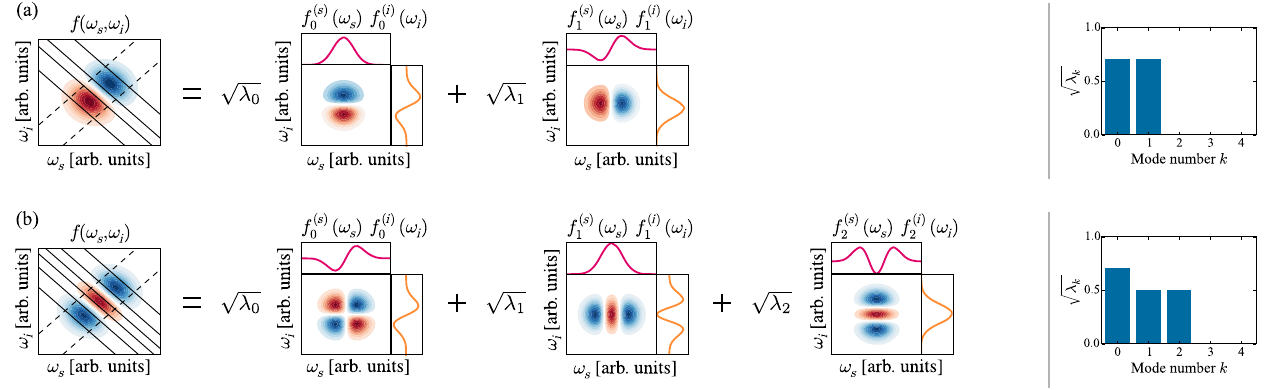
FIG. 6. (a) When pumping a dispersion-engineered PDC with a first-order Hermite-Gaussian pulse, the resulting JSA (left) has a negative part signified by the red color. Note that the pump envelope function is again denoted by solid black lines, whereas the phase- matching function is shown as dashed black lines. A decomposition of this JSA yields exactly two pairs of TMs (center) with similar expansion coefficients (right). Hence, the generated state is a TM Bell state. (b) By further increasing the order of the Hermite-Gaussian pump, it is possible to successively add TM pairs to the generated state. This state features an extremely well-defined dimensionality, although the relative weights of the modes become